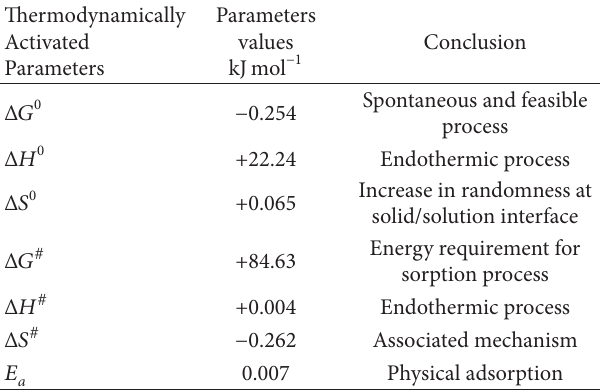
T 4: ermodynamical and activation parameters for sorption of Co(II) on SB.